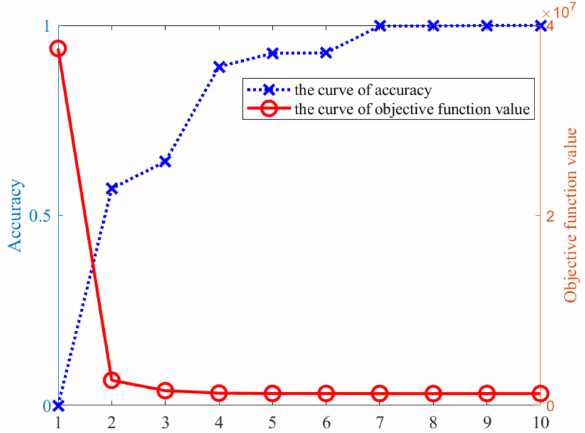
Figure 5. The objective function value and classification accuracy of CFM-HTD under different numbers of iterations.